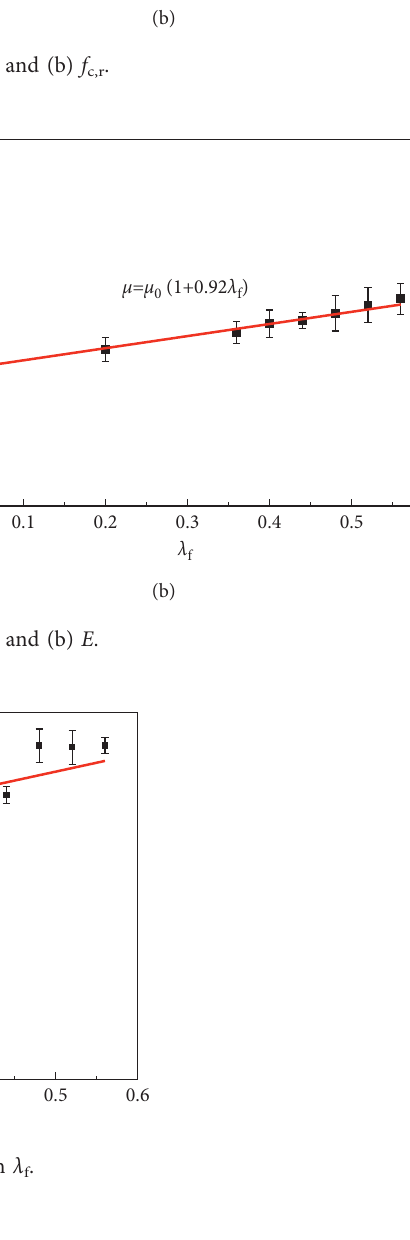
Figure 4: Relationship of λ